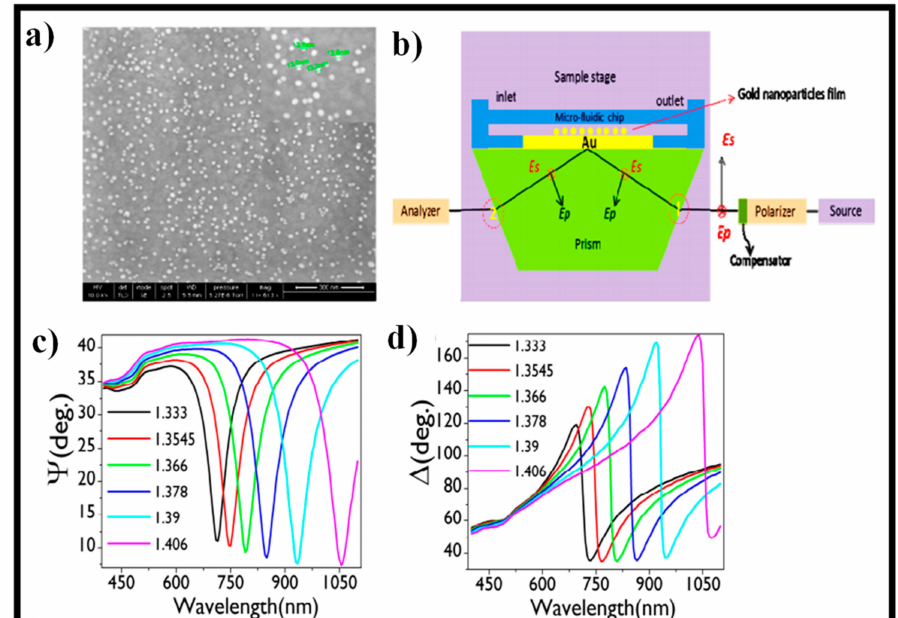
Figure 13. ( a ) Distribution of AuNPs on the Au surface after 1-min treatment of amine-functionalized Au substrate. Reprinted from ref. [226]; ( b ) graphical illustration of the experimental setup with optical components showing the polarization of the incident and reflected light within the prism for a sample attached perpendicular to the sample stage. Reprinted from ref. [226]; ( c , d ) spectral response of the ellipsometric parameters Ψ , ∆ for glycerol-water mixtures having different refractive indices introduced on 30 min treated AuNPs-coated Au substrate. Reprinted from ref.